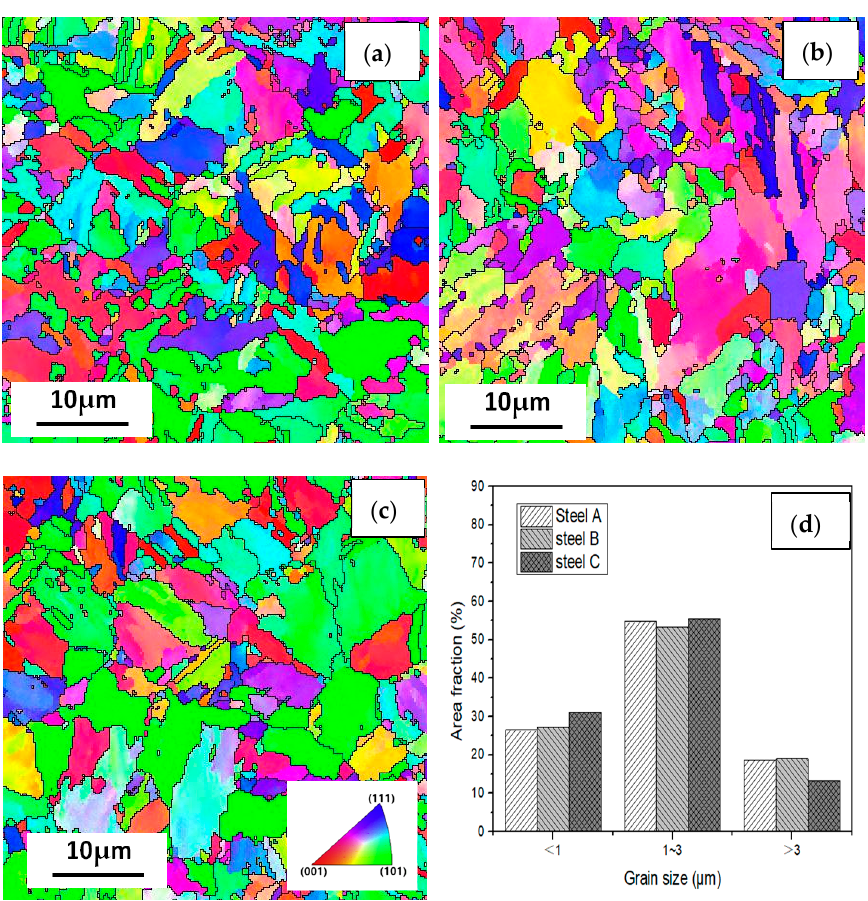
Figure 12. IPF maps at the cross section (RD-TD) planes for ( a ) steel A, ( b ) steel B and ( c ) steel C specimens; and ( d ) the histograms showing their grain size distributions.